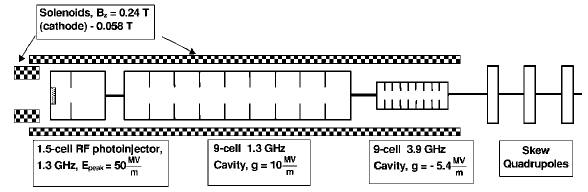
FIG. 1. Sketch of the electron beam source layout.